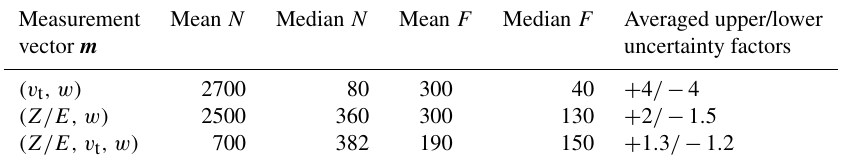
Table 3. Means, median and errors for the retrieval of N and F for the case study for different versions of m at 4500m